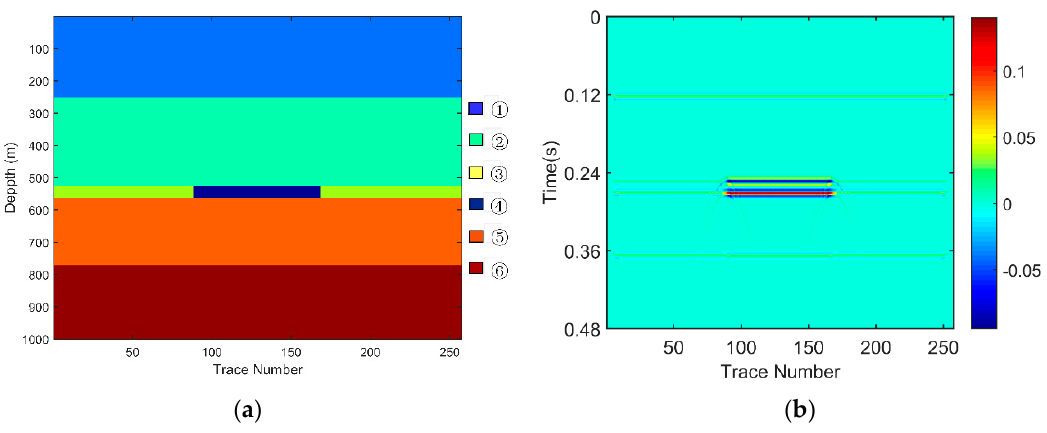
Figure 6. ( a ) Geological model; and ( b ) the simulated seismic section of the model. Table 1. Main parameters for the geological model.